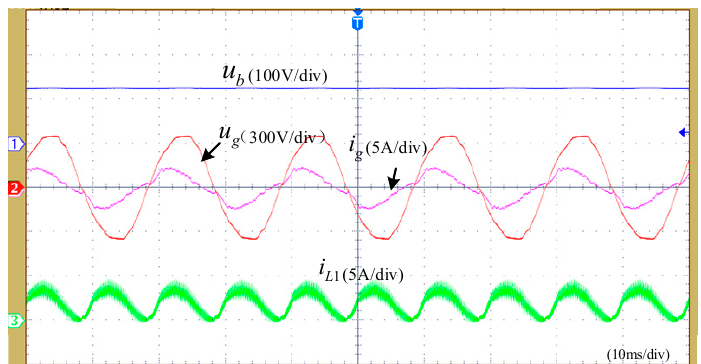
Figure 9. The experimental waveform of the presented converter operating in charging mode under a unity power factor ( P = 400 W, Q = 0 var, (cid:1855)(cid:1867)(cid:1871)(cid:2030) = 1 ).